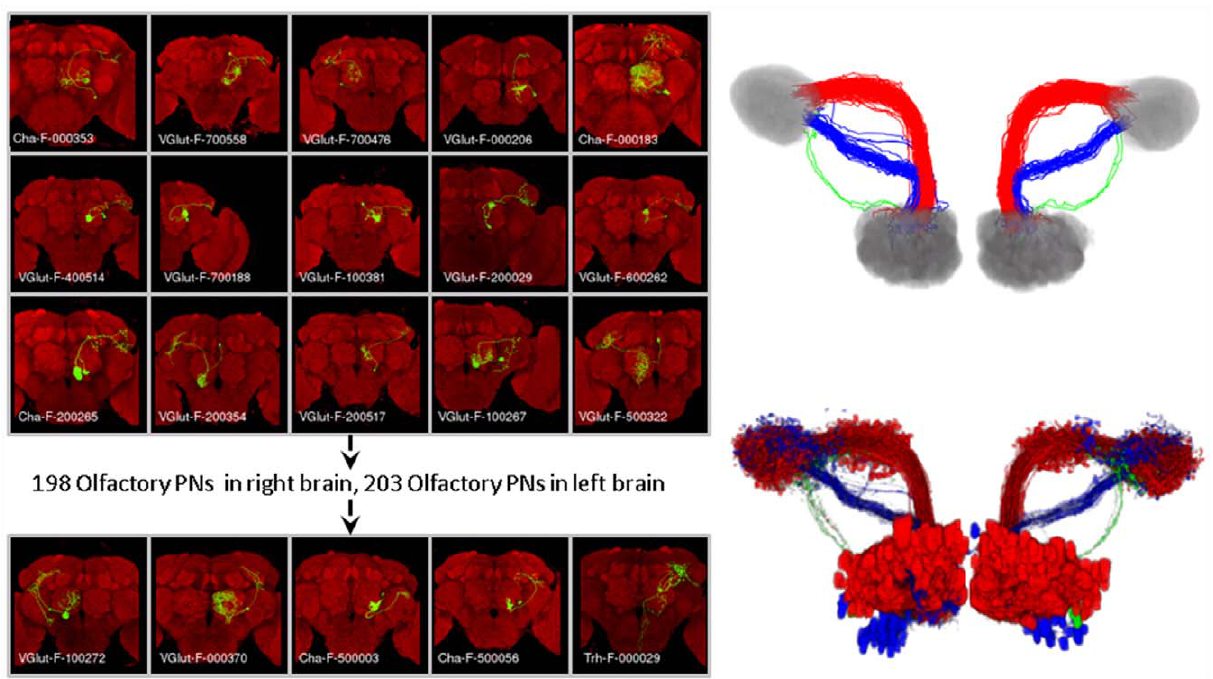
Figure 3. An illustration of olfactory PNs collection (left), the computed tract clusters (upper right) and the neuron image clusters overlapping the computed cluster (lower right). Totally 198 olfactory PNs in the right hemisphere and 203 olfactory PNs in the left hemisphere were selected.